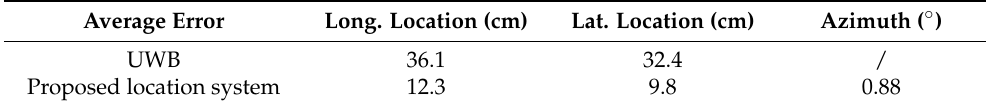
Table 2. Statistical location errors.